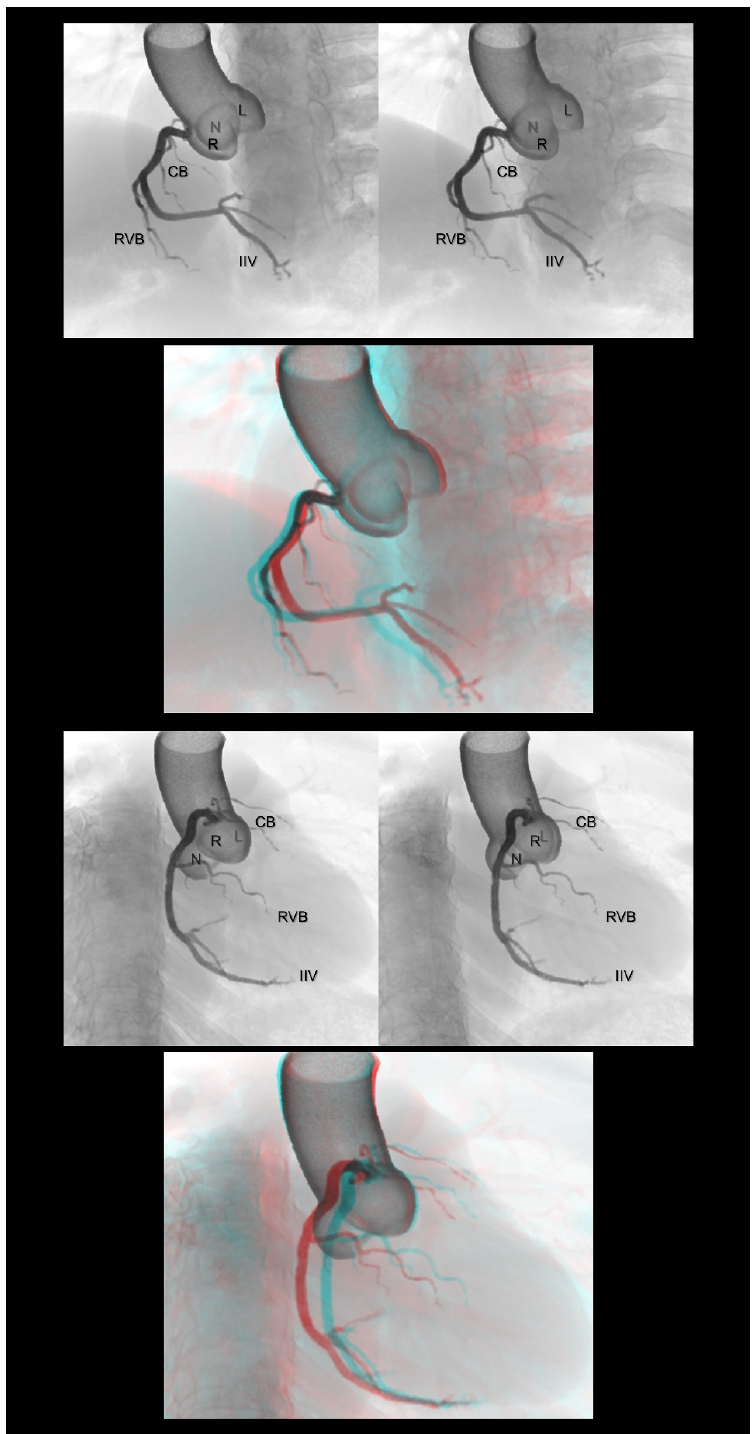
Figure 2. Left anterior oblique cranial view ( upper panels ) and right anterior oblique caudal view ( lower panels ) of the right coronary artery. Three-dimensional understanding of the coronary angiography in relation to each coronary aortic sinus is fundamental before learning the procedure. The first and second panels are aligned for cross ‐ eyed viewing. The third panel is the anaglyph. To see the anaglyph, anaglyphic glasses (red/cyan) are required. CB, conus branch; IIA, inferior interventricular artery; L, left coronary aortic sinus; N, noncoronary aortic sinus; R, right coronary aortic sinus; RVB, right ventricular branch.